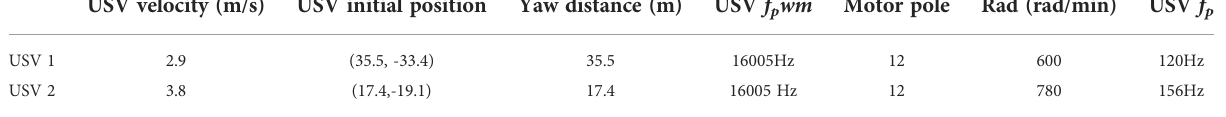
TABLE 1 USV navigation